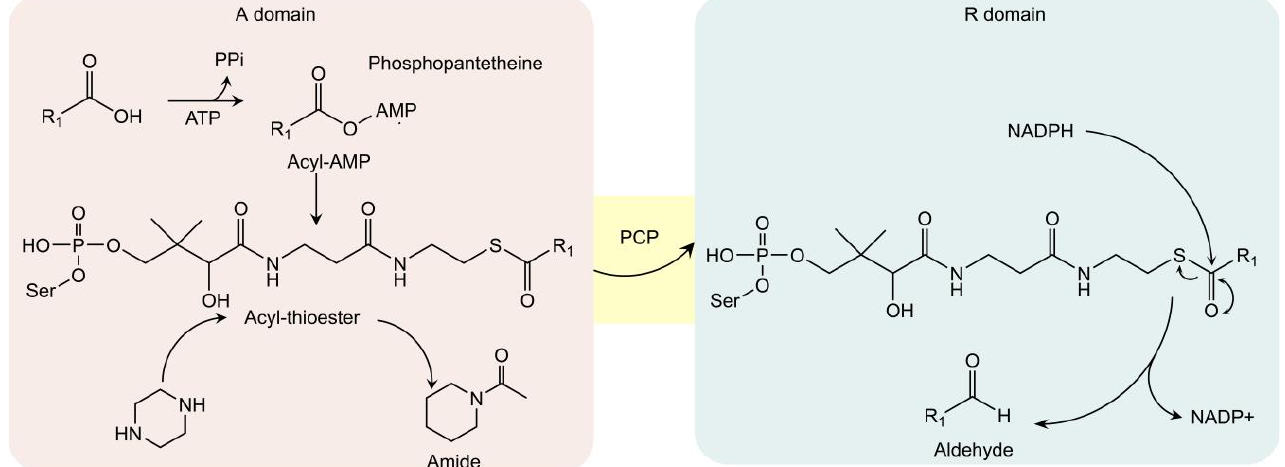
Figure 3. The A-domain of carboxylic acid reductase (CAR) presents amidation activity towards N-heterocycles. The A, R domains and peptidyl carrier protein (PCP) are shown in red, blue, and yellow. In the absence of NADPH, acyl-thioester intermediates react with variable amines (including piperazine) for amide formation in the A domain. On the other hand, the acyl-thioester intermediate is eventually reduced (by NADPH) into aldehyde in the R